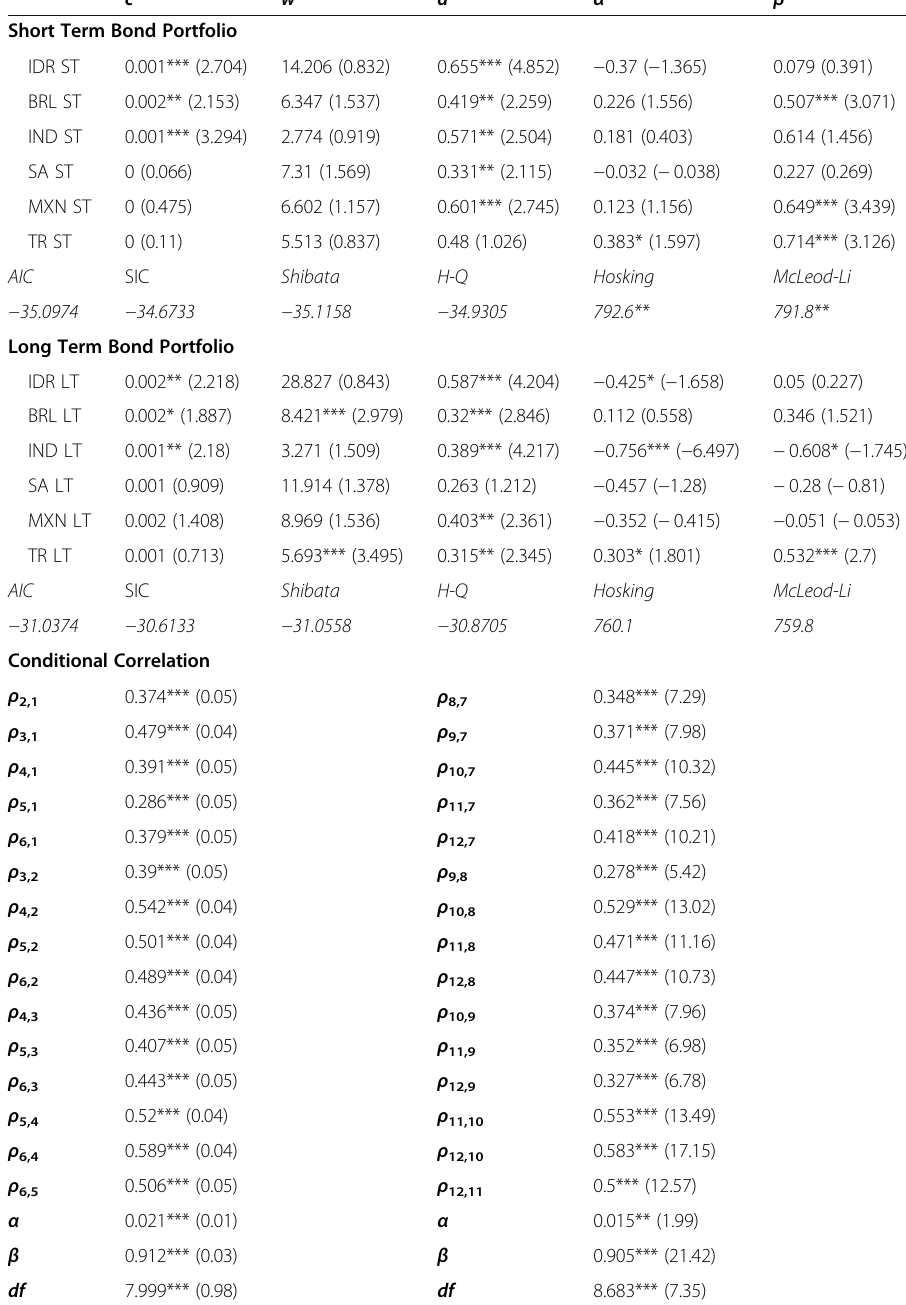
Table 4 DCC FIGARCH